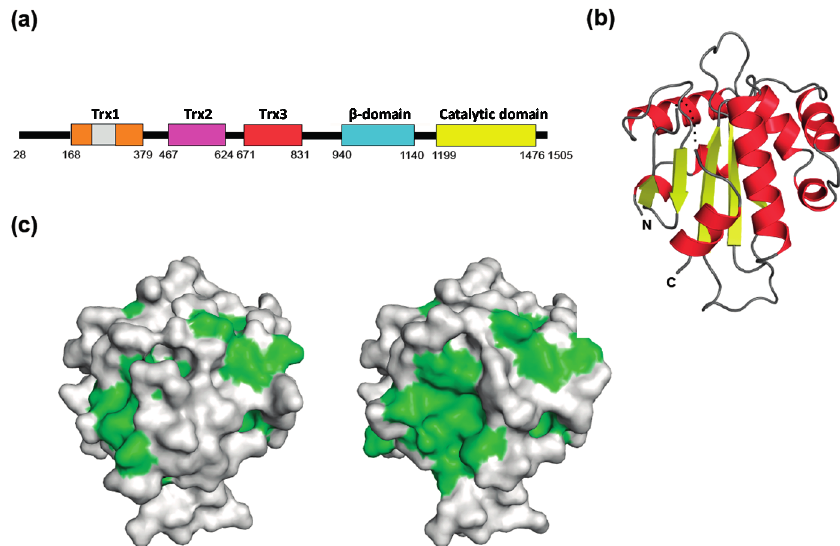
Figure 3. ( a ) Domain architecture of the thermophilic fungal UGGT; ( b ) Ribbon models of the third Trx domain of the Chaetomium thermophilum UGGT (closed form, PDB code: 3WZT) [33]. The secondary structures are highlighted ( α -helix, red; β -sheet, yellow), while the linker regions are indicated in gray. Dotted line indicates disordered segment; ( c ) Surface models of the closed and open (PDB code: 3WZS) forms of the Trx3 domain are shown on the left and right, respectively. The hydrophobic residues are shown in